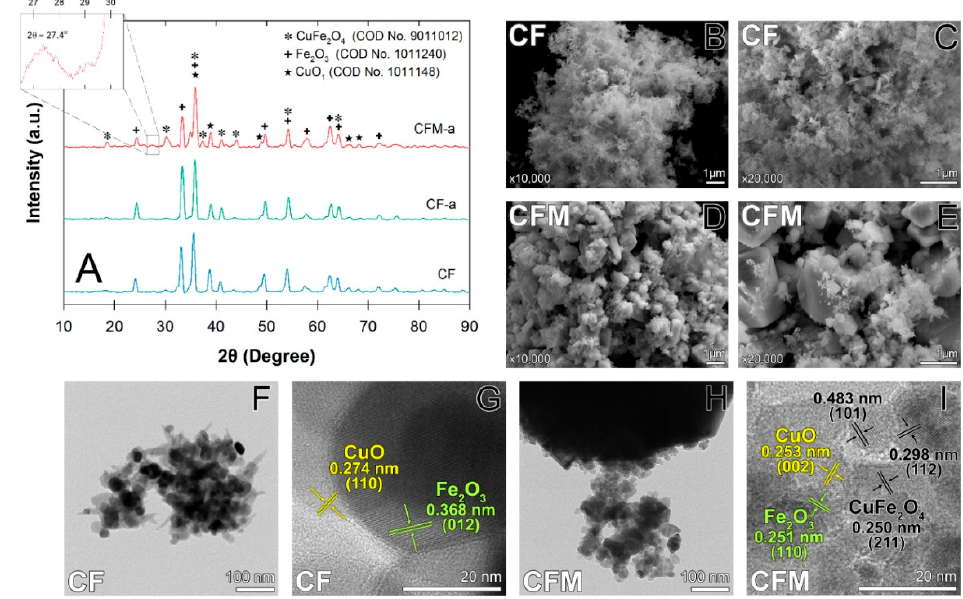
Figure 2. CuFe 2 O 4 /CuO/Fe 2 O 3 ternary nanocomposites: ( A ) XRD patterns of catalysts before and after catalytic ozonation, ( B , C ) CF SEM images, ( D , E ) CFM SEM images, ( F , G ) CF TEM images, ( H , I ) CFM TEM images.